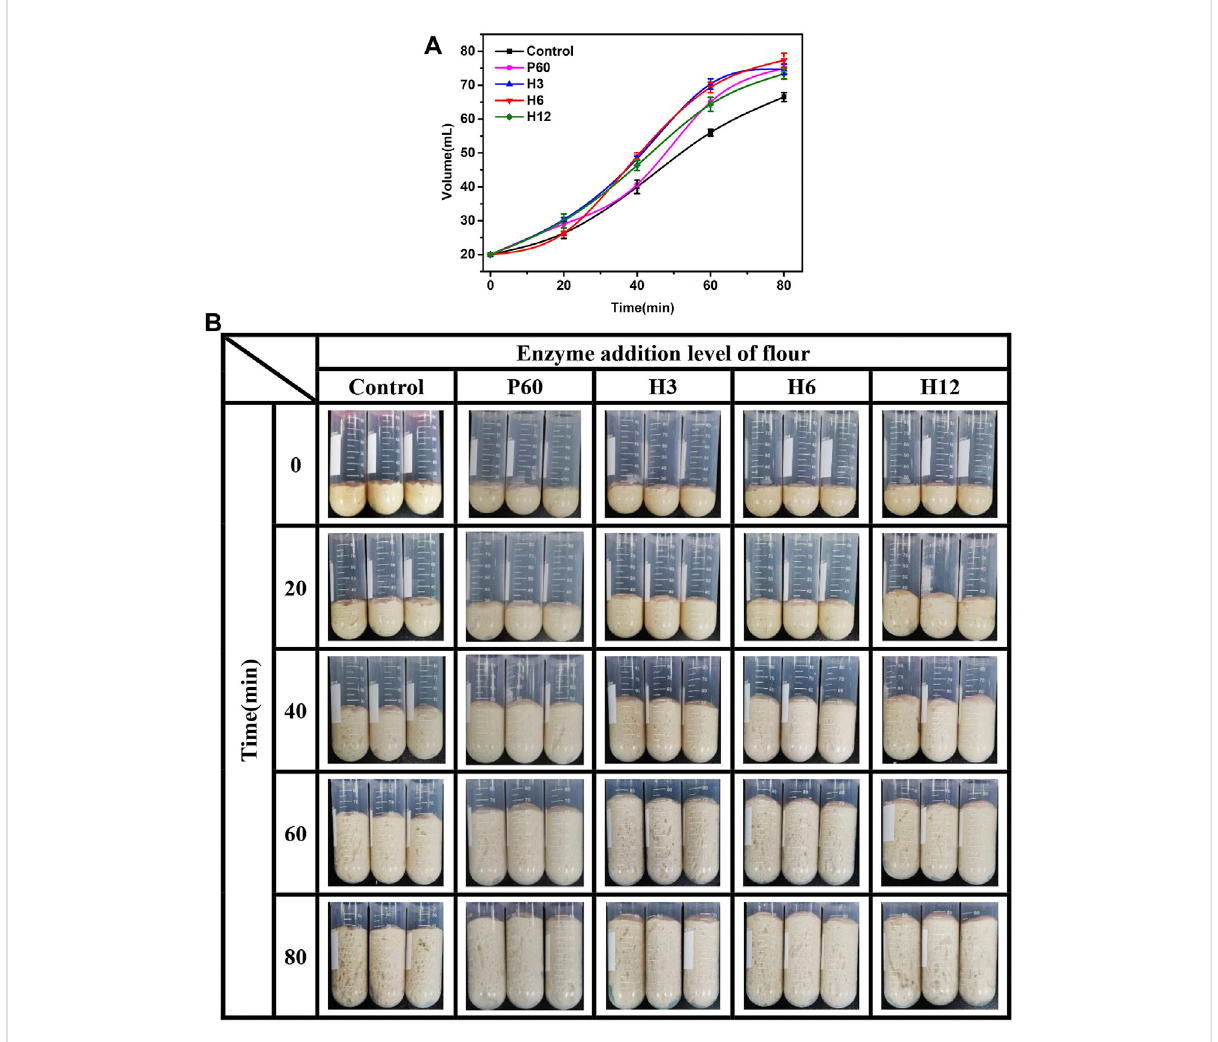
FIGURE 5 Effect of Hmxynadditionon dough fermentation. (A) Curve ofvolume of fermenteddough with time-variation. (B) Photosoffermenteddough with time-variation. Control: control sample; H3-H12: dough prepared with the addition of 3, 6, and 12 mg Hmxyn per 1 kg wholewheat fl our. P60: dough prepared with the addition of 60 mg Pentopan Mono BG per 1 kg wholewheat fl